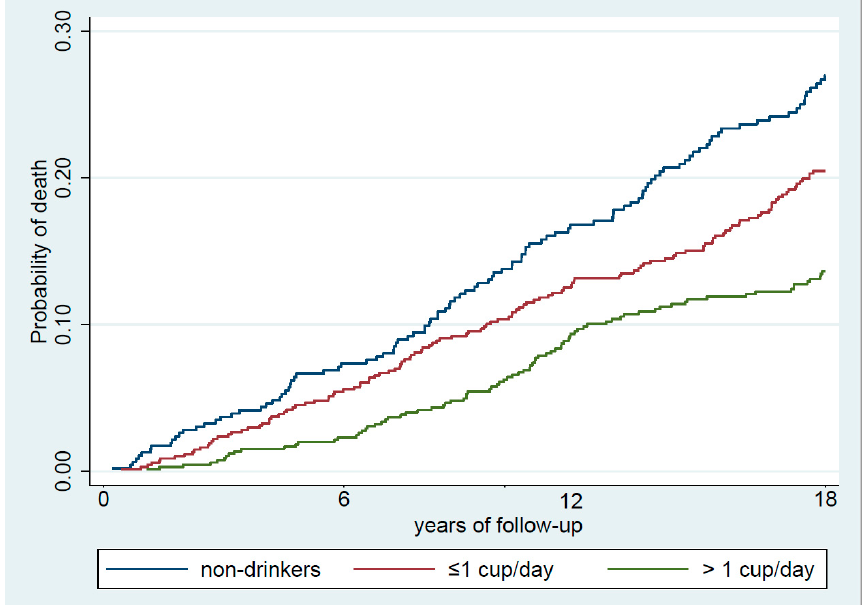
Figure 1. Cumulative incidence curves of death after 18 years of follow-up, according to total coffee consumption for all-cause mortality in participants from the Valencia Nutritional Survey in Spain ( n = 1567).